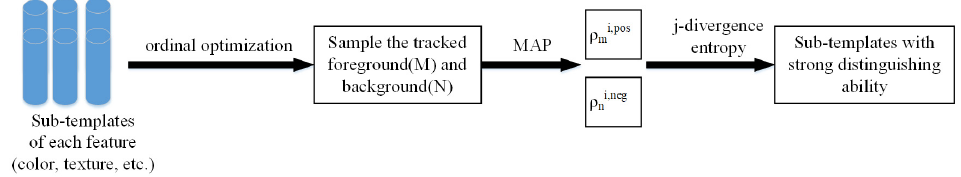
Figure 2. The selection process of feature